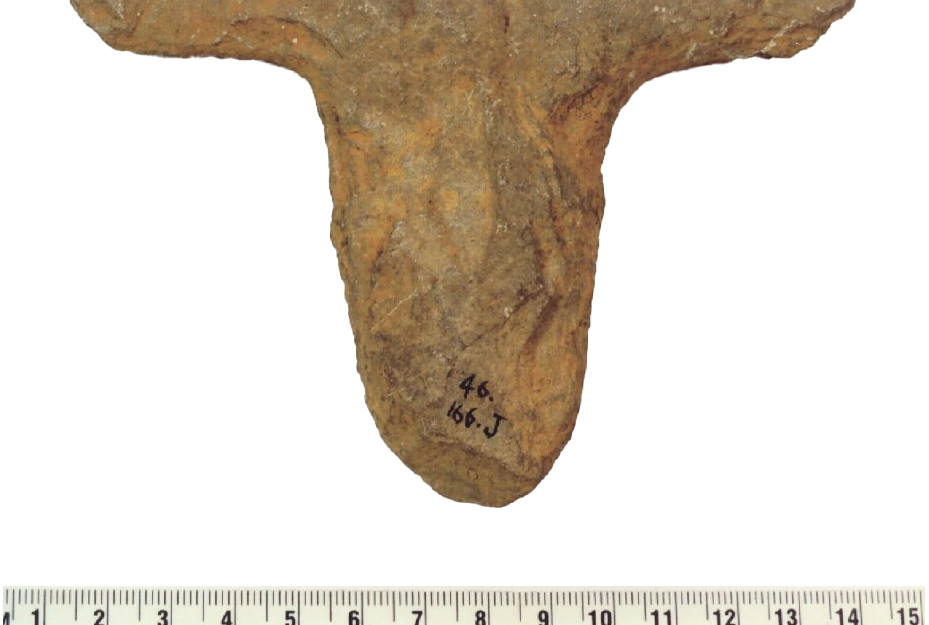
Figure 7. Close-up photograph of tool tang end with prepared striking platform visible just below catalogue number (by Healy, courtesy of the Cambridge University Museum of Archaeology and Anthropology, Cat. No. 1946.166J; scale in